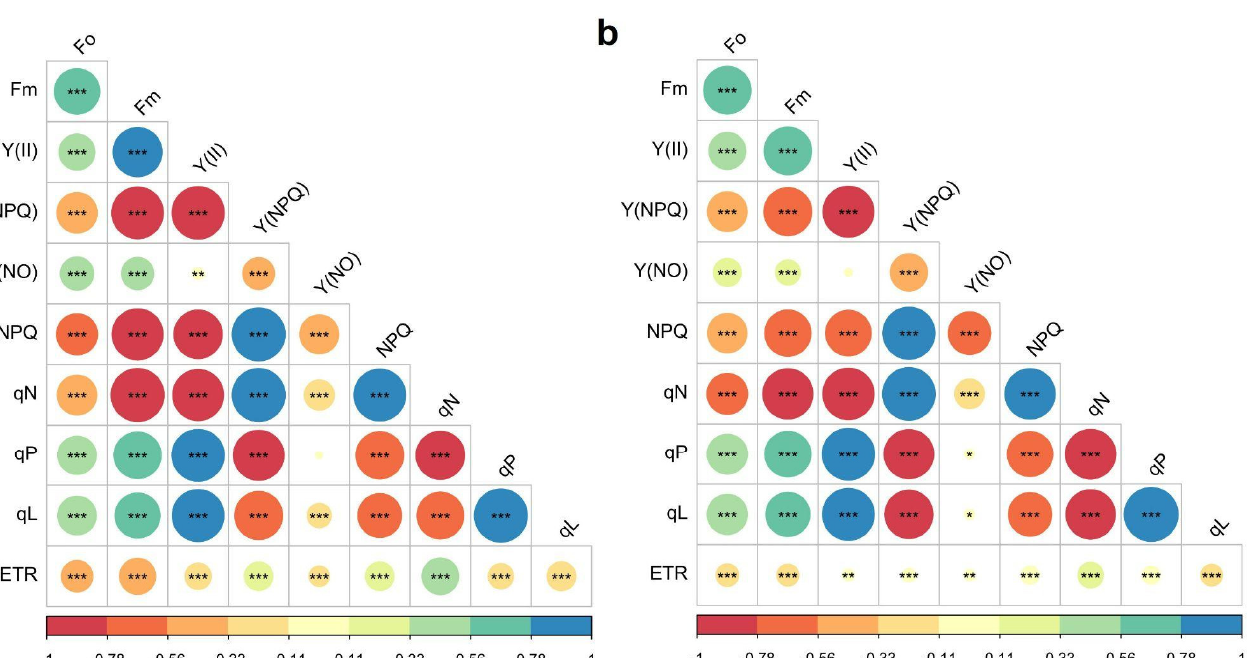
resistant, moderately susceptible, susceptible and highly